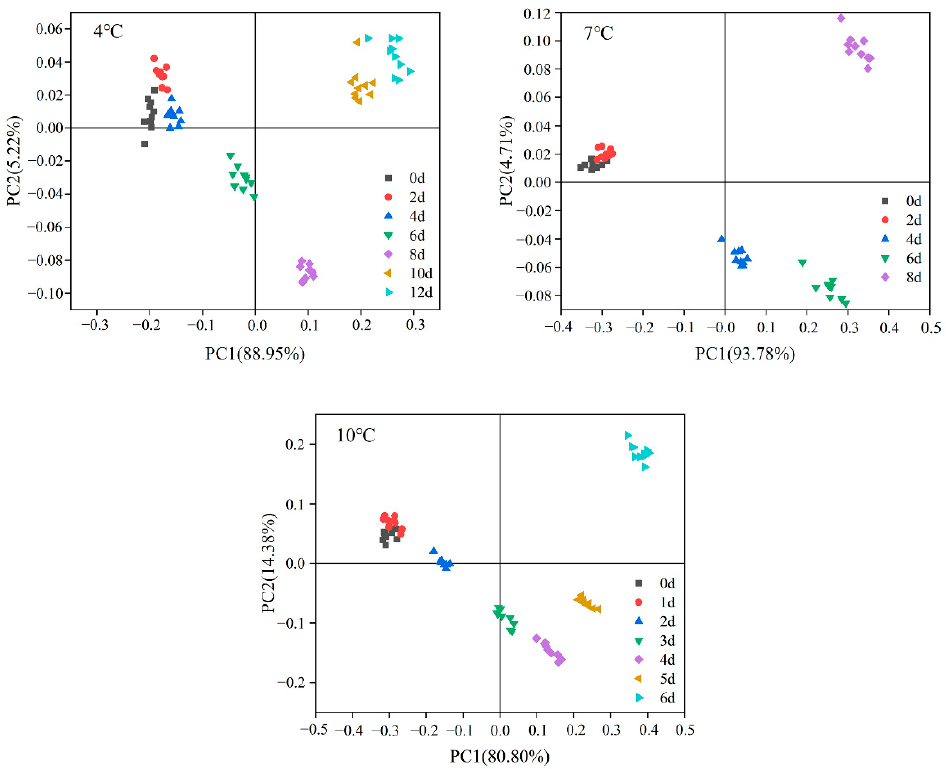
Figure 3. PCA score plots based on electronic nose measurements of tuna inoculated with S. Putre- faciens with different incubation times.